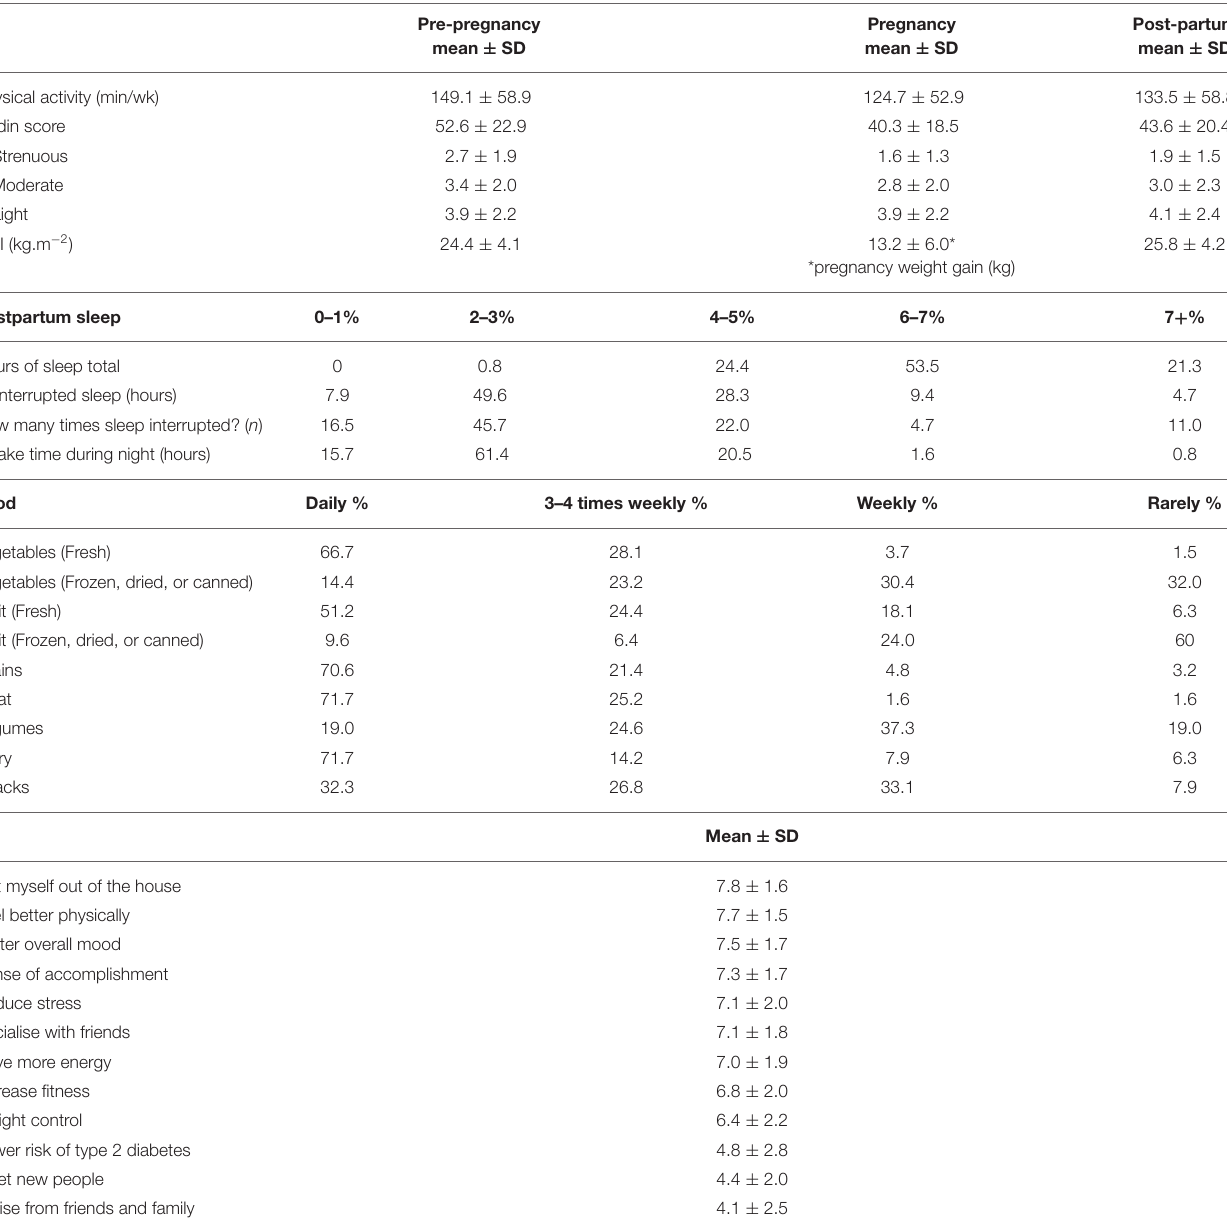
TABLE 1 | Physical activity, body mass index (BMI), sleep, dietary intake, and perceived value of achieving outcomes of women reported pre-, during, and post-pregnancy (during COVID-19 social distancing restrictions). Pre-pregnancy mean ±